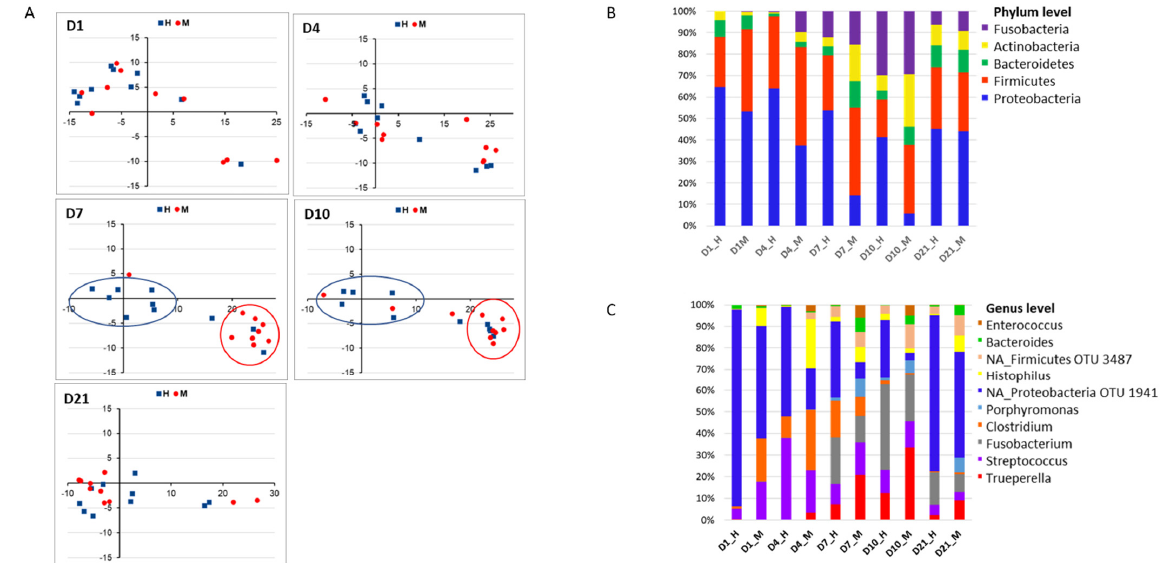
Figure 4. Comparison of the taxonomic composition of postpartum uterine microbiomes between healthy (H) and metritis (M) animals. ( A ) NMDS plots based on Bray-Curtis dissimilarity distances between postpartum uterine microbiomes of individual cows for each time point. Individual points represent single cows ( T = 10 for each group). Blue—healthy cows; Red—metritis cows. Bar graphs showing averaged relative abundances and distribution for the top 5 phyla ( B ) and top 10 genera ( C ). Unclassified genera are denoted by NA. Relative abundances were rescaled to account for only the 5 (phyla) and 10 (genera) most abundant phyla.